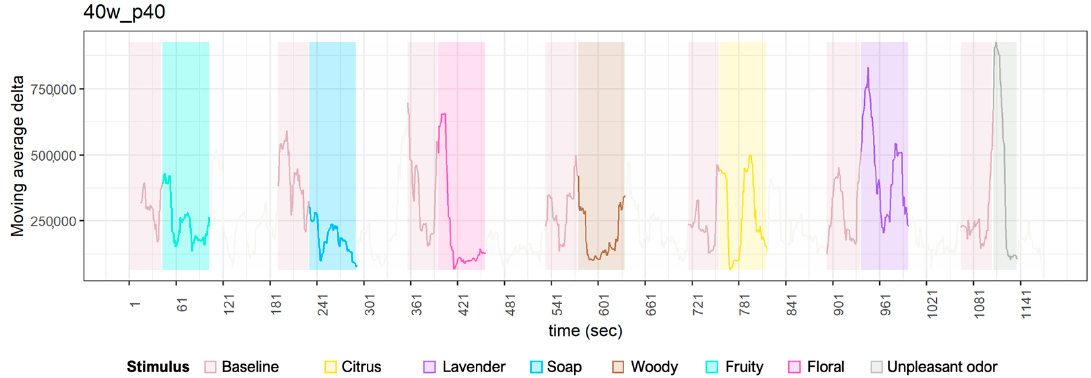
Figure A4. Time series plot of delta wave of one participant from the female 40s–50s group. The lines indicate the moving average values of delta wave Y -axis) against the time ( X -axis) from the beginning to the end of the experiment. Di ff erent colors indicates di ff erent experiment conditions (olfactory stimuli or resting as baseline).